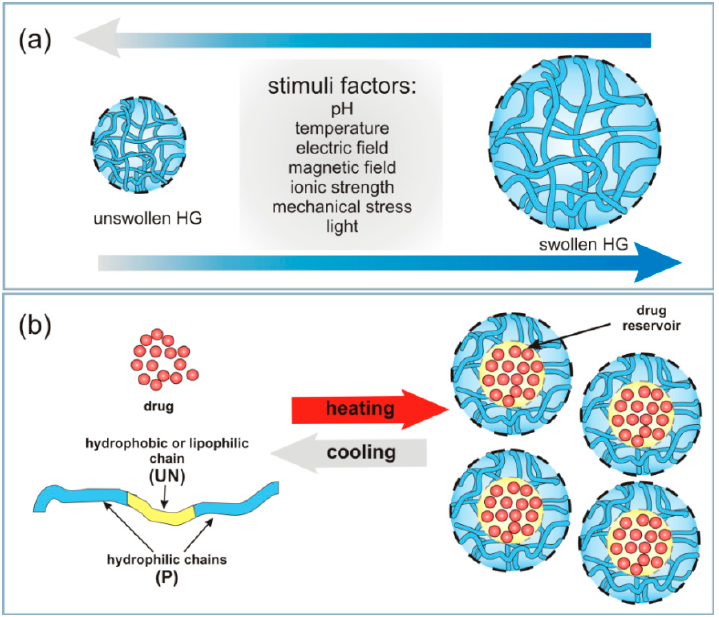
Figure 1. ( a ) Types of stimuli causing HG swelling. ( b ) Schematic illustration of a thermo-reactive HG formation loaded with a drug that uses temperature as a stimulus.